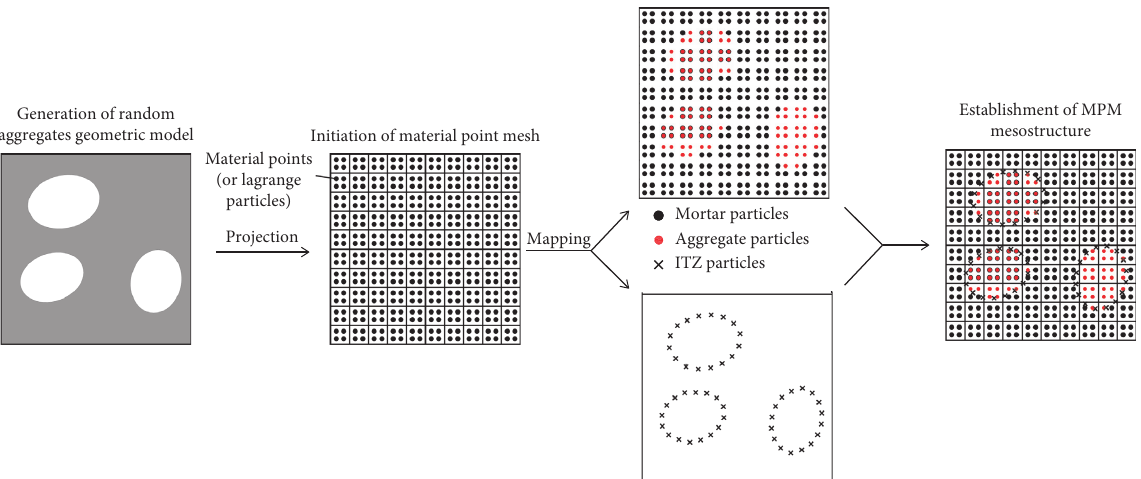
Figure 2: Discretization of material point of a concrete specimen.